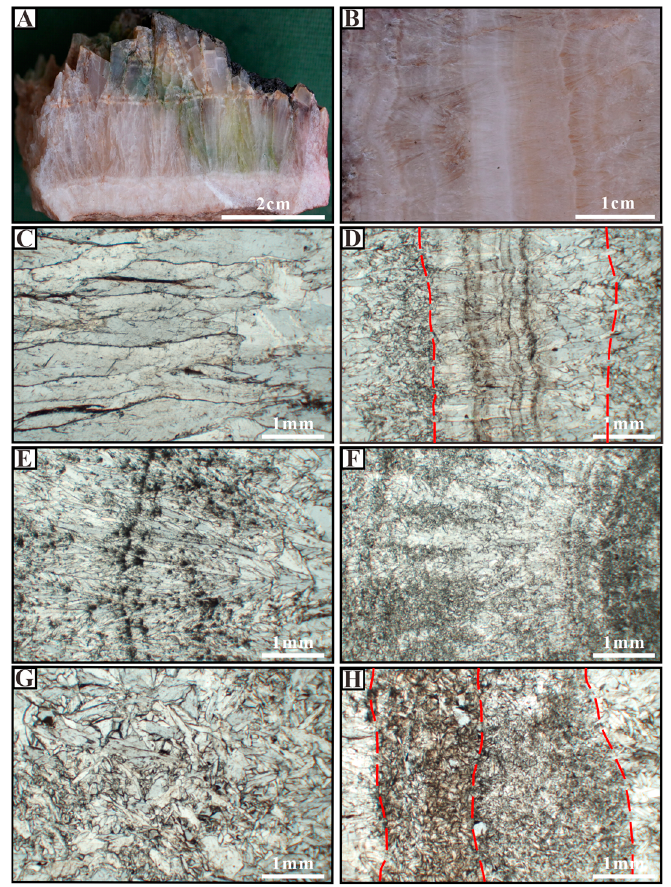
Figure 3. Hand specimens ( A , B ) and microphotographs ( C – H ) of the main petrographic character- istics of the studied banded travertines. ( A ) Cross-section of thick-laminated palisade crystalline crust. ( B ) Polished side of thin-laminated composite crystalline crust. ( C ) cm-size elongated palisade crystals. ( D ) Short-columinar calcite crystals. ( E ) Feather-like dendritic crystals. ( F ) Dendritic crys- tals with blurry edges and numerous microcrystals filling intercrystalline pores. ( G ) Willow leaf bladed-like calcite crystals, and intercrystalline microcrystals. ( H ) Bands of dark granular crystals and calcite micrite.